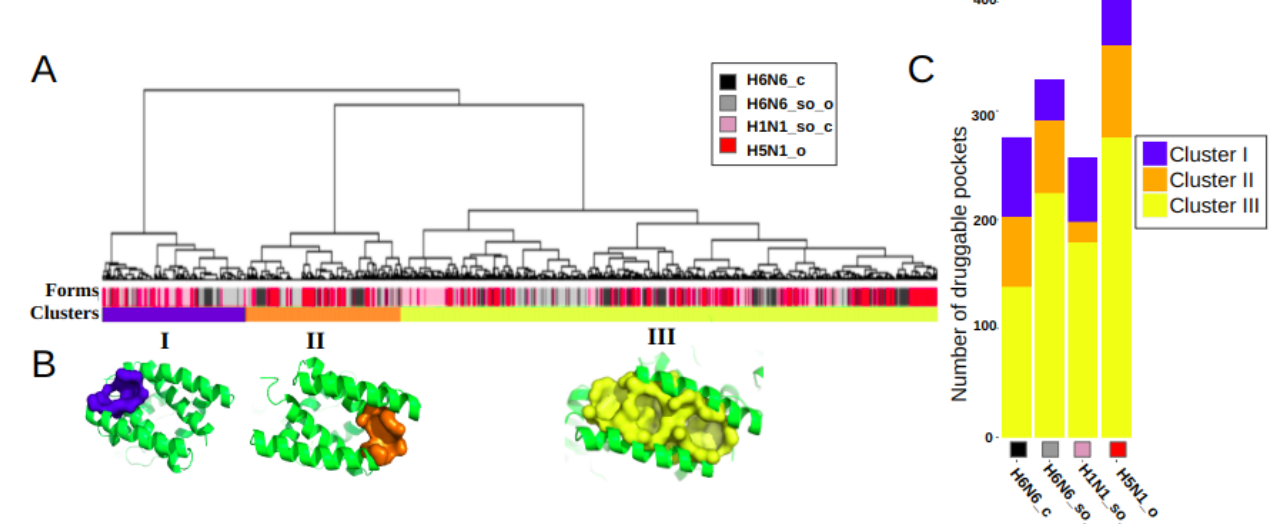
Figure 2. Classification and representation of the three main identified druggable groove-pocket clusters: ( A ) Hierarchical classification of druggable groove-pockets extracted from the MD simula- tions of the four crystallographic NS1 structures (H6N6_c, H6N6_so_o, H1N1_so_c and H5N1_o), indicated by the colors black, gray, pink and red, respectively, on the Forms line. Three clusters (I, II and III) were identified in the Clusters line, colored blue, orange and yellow, and comprising 220, 236 and 816 druggable groove-pockets respectively. ( B ) Representative pockets of three binding sites are illustrated on one representative groove conformation, in blue, orange and yellow for clusters I, II and III, respectively. ( C ) Histogram of the distribution of druggable pockets per cluster for each of the H6N6_c, H6N6_so_o, H1N1_so_c and H5N1_o structures.